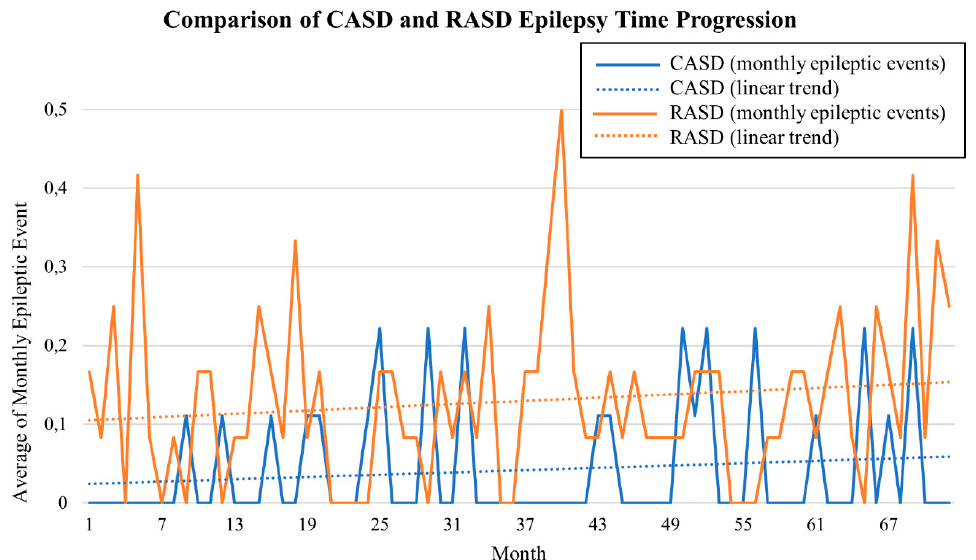
Figure 1. The graph represents oscillations in the presentation of epileptic events in CASD and RASD groups during the 6-year interval. The more frequent and higher spikes suggest a greater occurrence of seizures in the RASD group. Conversely, the seizure-free period reaches the zero level more often and for longer timespans in the CASD group. This trend tends to remain stable across the period of observation.